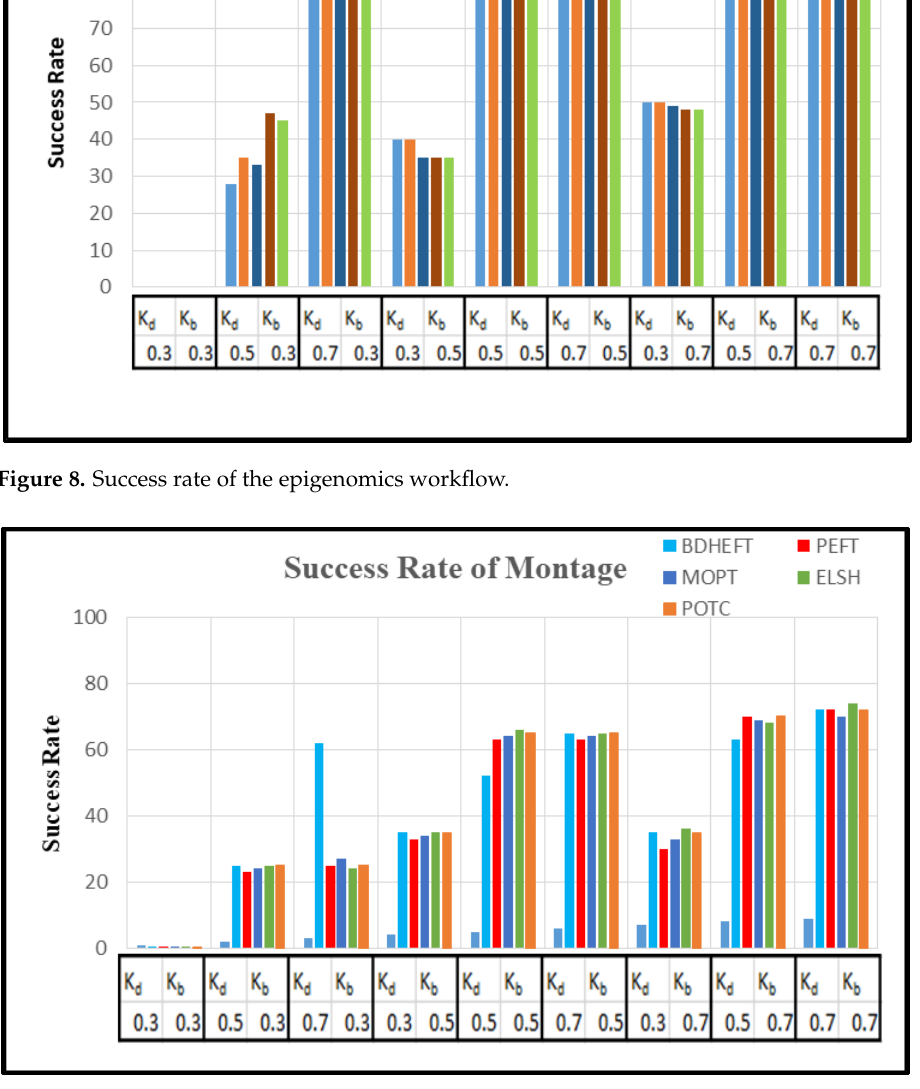
Figure 9. Success rate of the montage workflow.